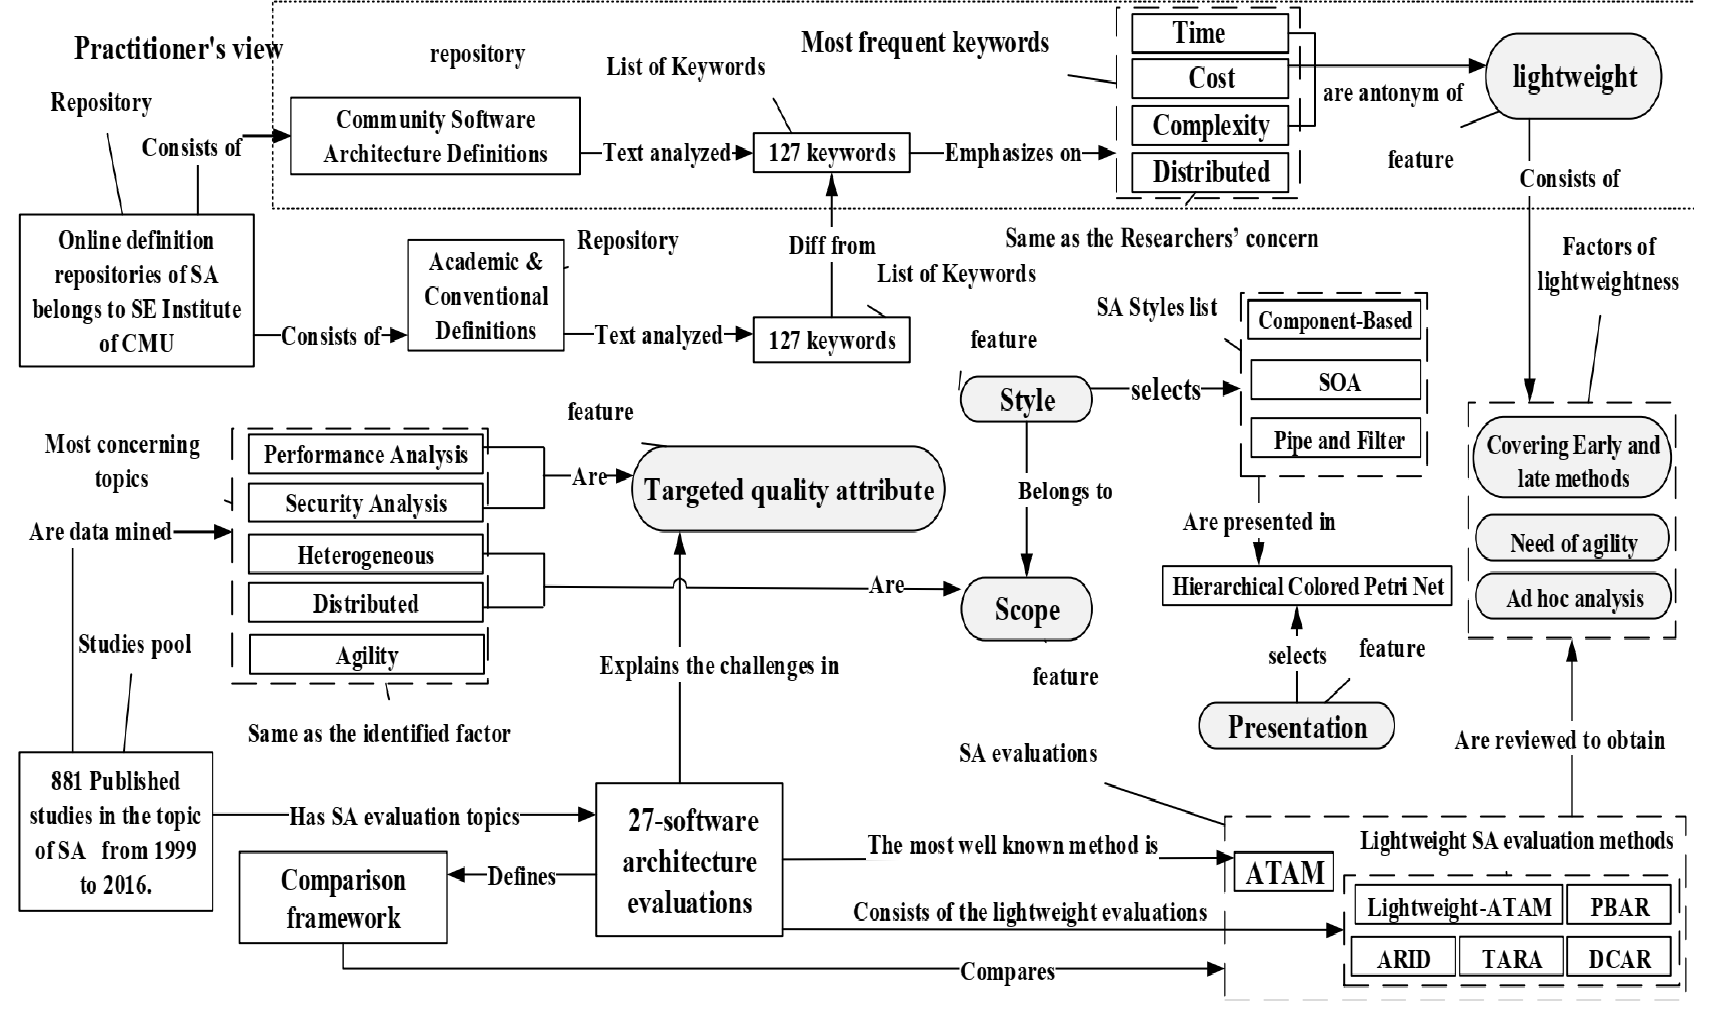
Figure 3. Identifying features and lightweight factors.